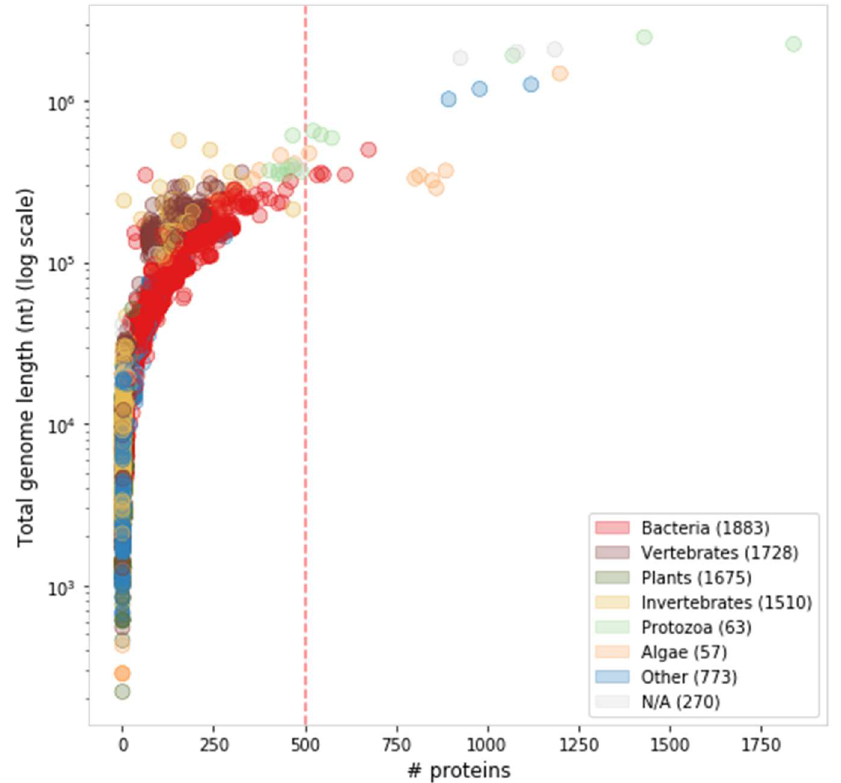
Figure 2. Distribution of viral proteome and genome sizes, colored by host taxonomy. There are 24 represented genomes that meet the threshold of ≥ 500 proteins (dashed red line), comprising five bacteria-infecting and 19 eukaryote-infecting viruses.